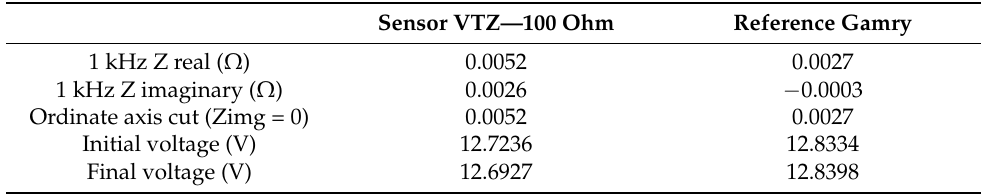
Table 2. Resistances measured at 1 kHz and the voltage parameter variations before and after EIS measurements with the 100 Ω